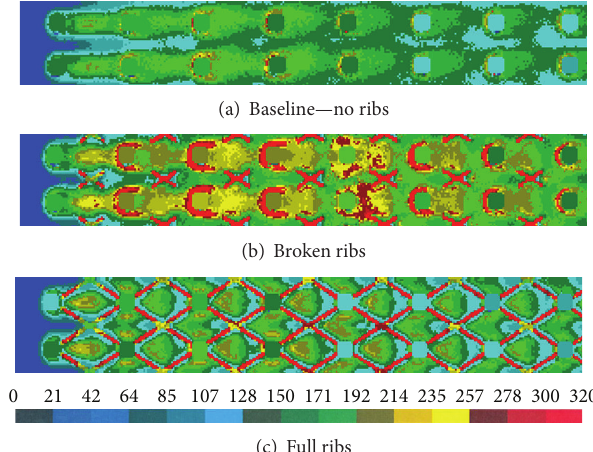
Figure 15: Local dimensional heat transfer coefficient distributions (W/m 2 K)forconfigurationsshowninFigure14forRe=25,000from Siw et al. [6].